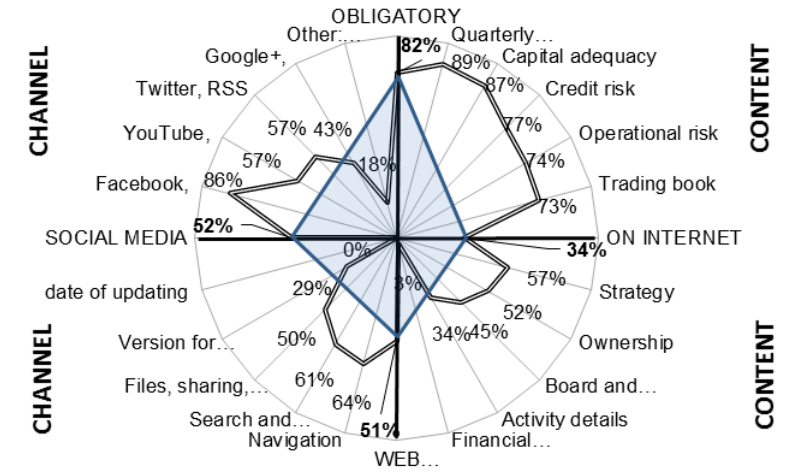
Fig. 3. E-transparency of banks: legal reporting, presence of general and specialized information on site, use of web technologies and social media The data contribute to the conclusion that e-transparency of banks is higher than average mostly because of their compliance to legal requirements and disclosing the obligatory information in financial reports.